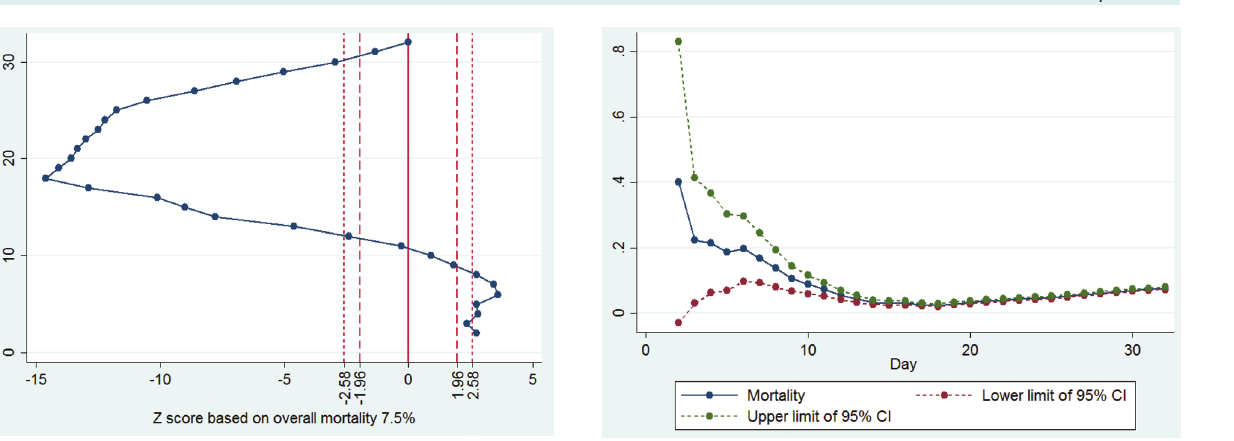
Figure 2 . A plot showing Z score changing of daily report of case fatality rate Figure 3. Trend of case fatality rate from day 2 to day 32. CI: confidence